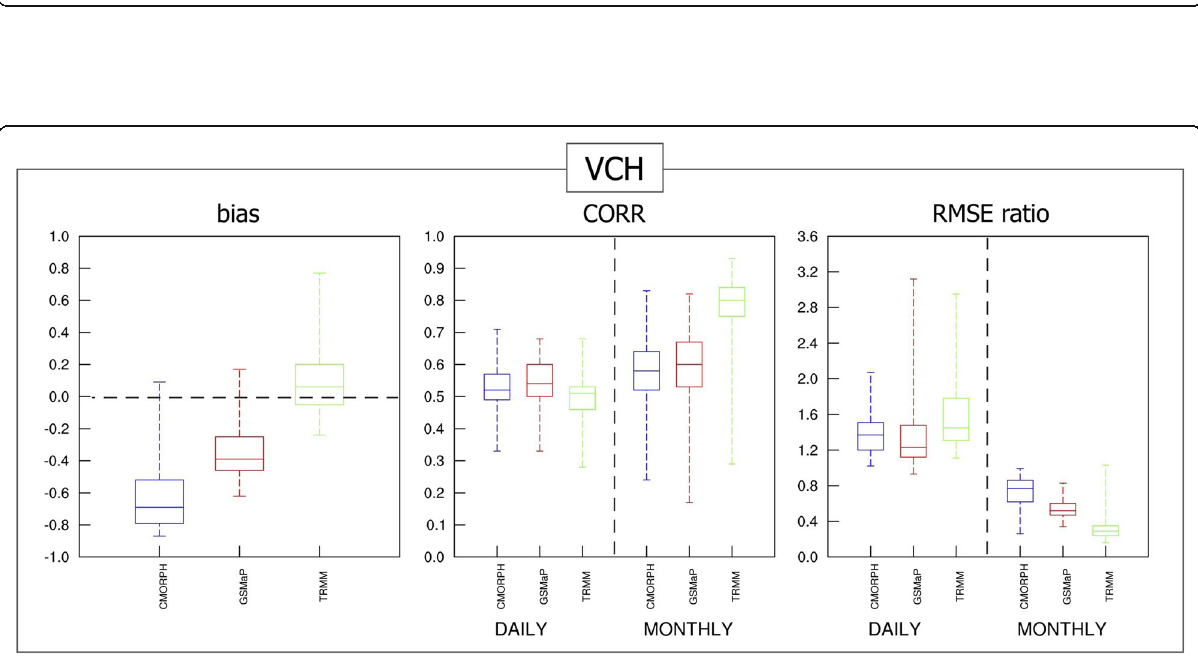
Fig. 5 Upper panels (from left): spatial patterns of 4 month (MJJA), 10 year (2001 – 2010) averaged daily rainfall for VnGP, and three SPDs (CMORPH, GSMaP and TRMM) over the VCH. Middle panels (from left): spatial patterns of 4month (MJJA), 10year (2001 – 2010) averaged daily rainfall difference between each SPD and VnGP. Lower panels (from left): CORR grid-point values between each SPD and VnGP for monthly rainfall in MJJA during 2001 – 2010